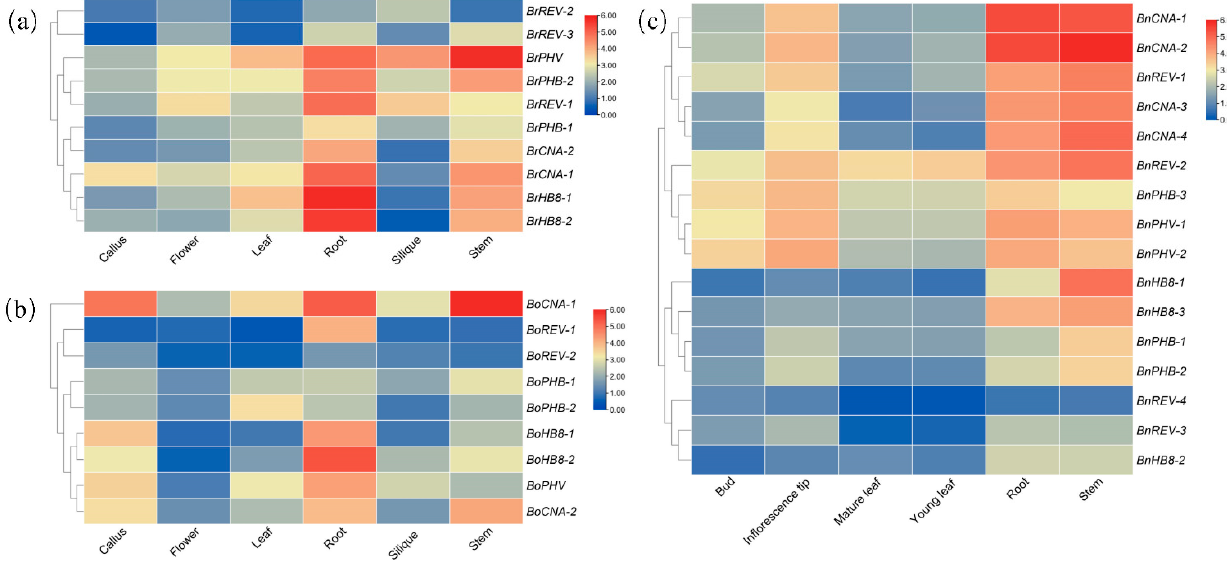
Figure 5. Expression profiling of the HD-ZIP III genes in different tissues. Expression profiling of the HD-ZIP III genes in B. rapa ( a ), B. oleracea ( b ) and B. napus ( c ). The heatmaps were built using log2-transformed FPKM values.